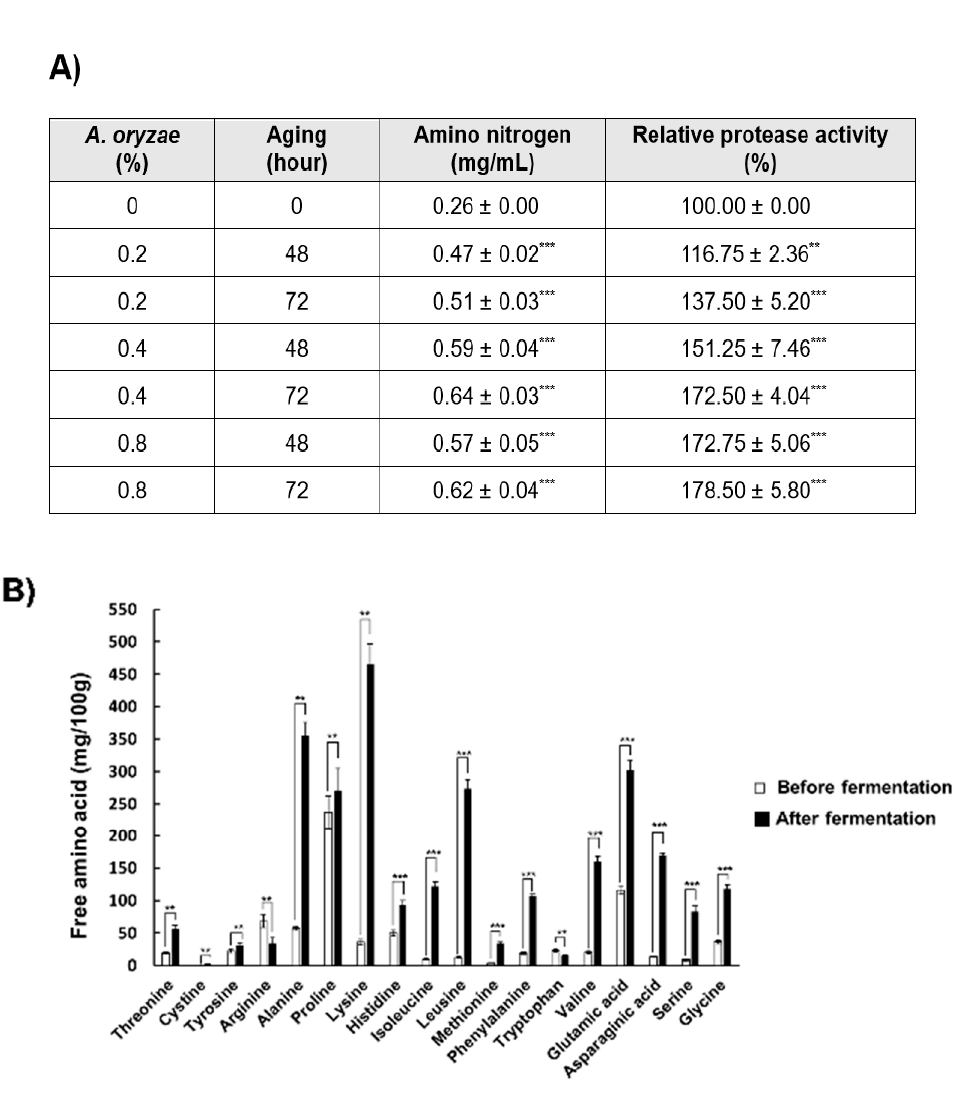
Figure 1. Evaluation of the fermentation of koji made with PBL. Quantitative analyses of the amino nitrogen content and protease activity ( A ) and the free amino acid content ( B ) of PBL koji were performed. Values are the means ± standard deviations of triplicate experiments. ** p < 0.01 and *** p < 0.001 indicate a significant difference between non ‐ aging and aging treatments.